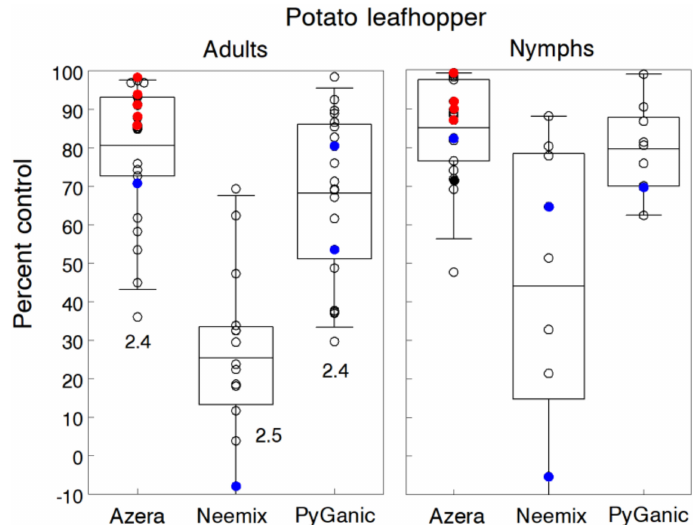
Figure 8. Percent control of potato leafhopper with weekly applications of Azera, Neemix and PyGanic relative to the untreated control. Mean data are given for adults and nymphs compiled from 4 trials on snap beans, 5 trials on alfalfa and 6 trials on potato. Box-whisker plots show the 25% and 75% percentile range of percent control data and the horizontal line in each box is the overall mean control e ffi cacy. Number below each adult plot indicates the average number of weekly applications. Application rates of Azera, Neemix, PyGanic and Entrust were 2.34 L / h, 1169 mL / h, 2.34 L / h and 71.2 g a.i. / h respectively, except for individual trial data in blue and red indicating lower and higher rates, respectively. Azera and PyGanic provided significantly higher control of adults compared to Neemix, but there were no significant di ff erences in nymph control among